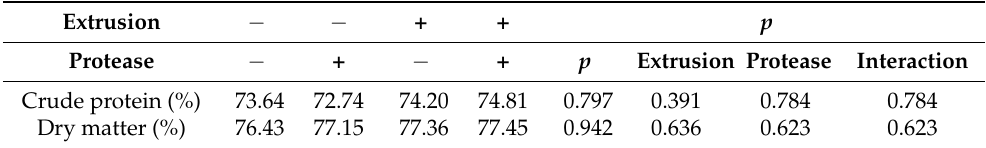
Table 4. The apparent ileal digestibility coefficients of crude protein and dry matter in the diets ( n = 8).